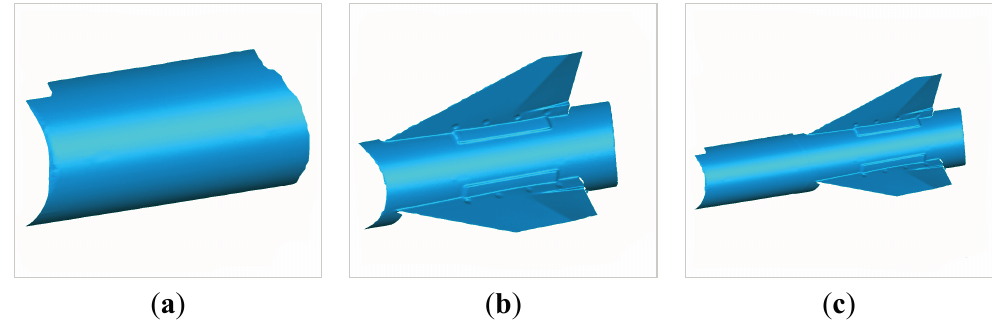
Figure 14. ( a ) 3D morphology of the missile model measured by the 3D scanning sensor at the first position; ( b ) 3D morphology of the missile model measured by the 3D scanning sensor at the second position; ( c ) united 3D morphology of the missile model measured by the 3D scanning sensor at two